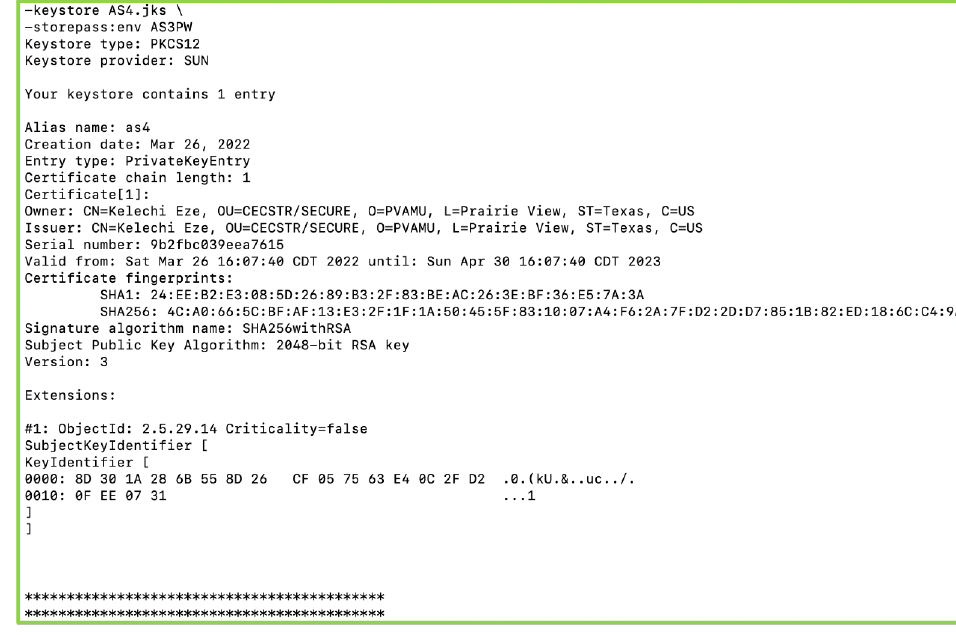
Figure 7. Private